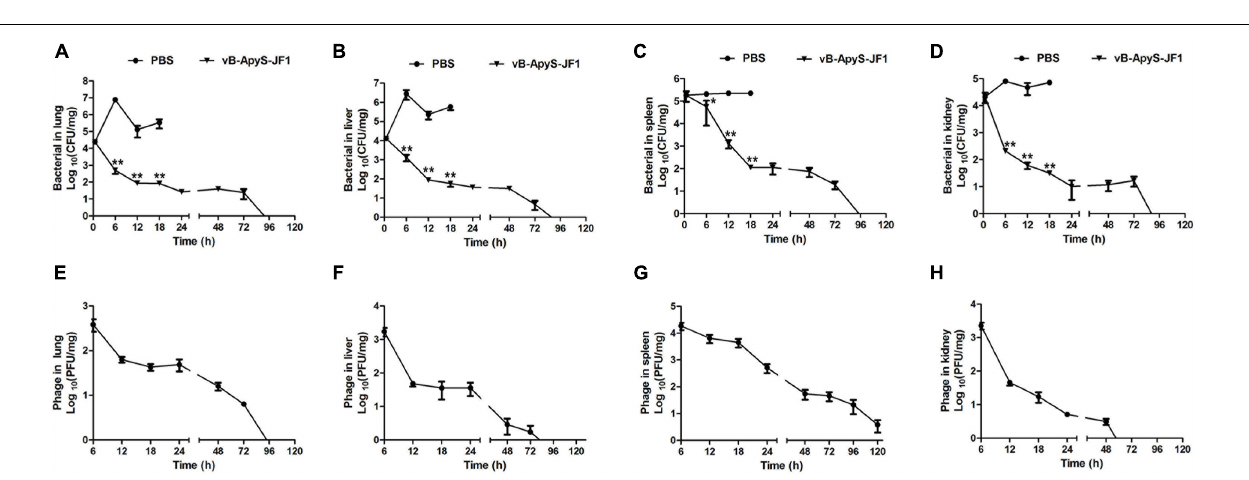
FIGURE 7 | Bacterial load and phage titers in mouse organs. The lung, liver, spleen, and kidney pieces of mice from each group were harvested and homogenized 0.5, 6, 12, 18, 24, 48, 72, 96, and 120 h after challenge. A total of 36 mice were used in this experiment. Three mice from each group were euthanized at each time point. (A–D) Fluid from each ground tissue was diluted multiple times, and the colony counts were determined. (E–H) The titers of phage JF1 were measured using the double-layer plate method. The values represent the means and standard deviations (SDs) ( n = 3). * P < 0.05; ** P <